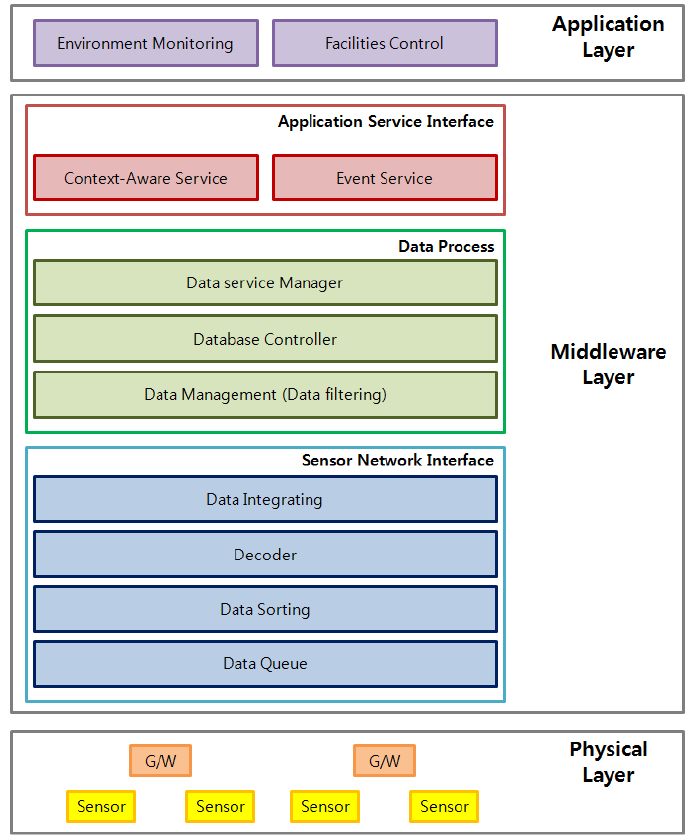
Figure 10. Hierarchical diagram of the proposed